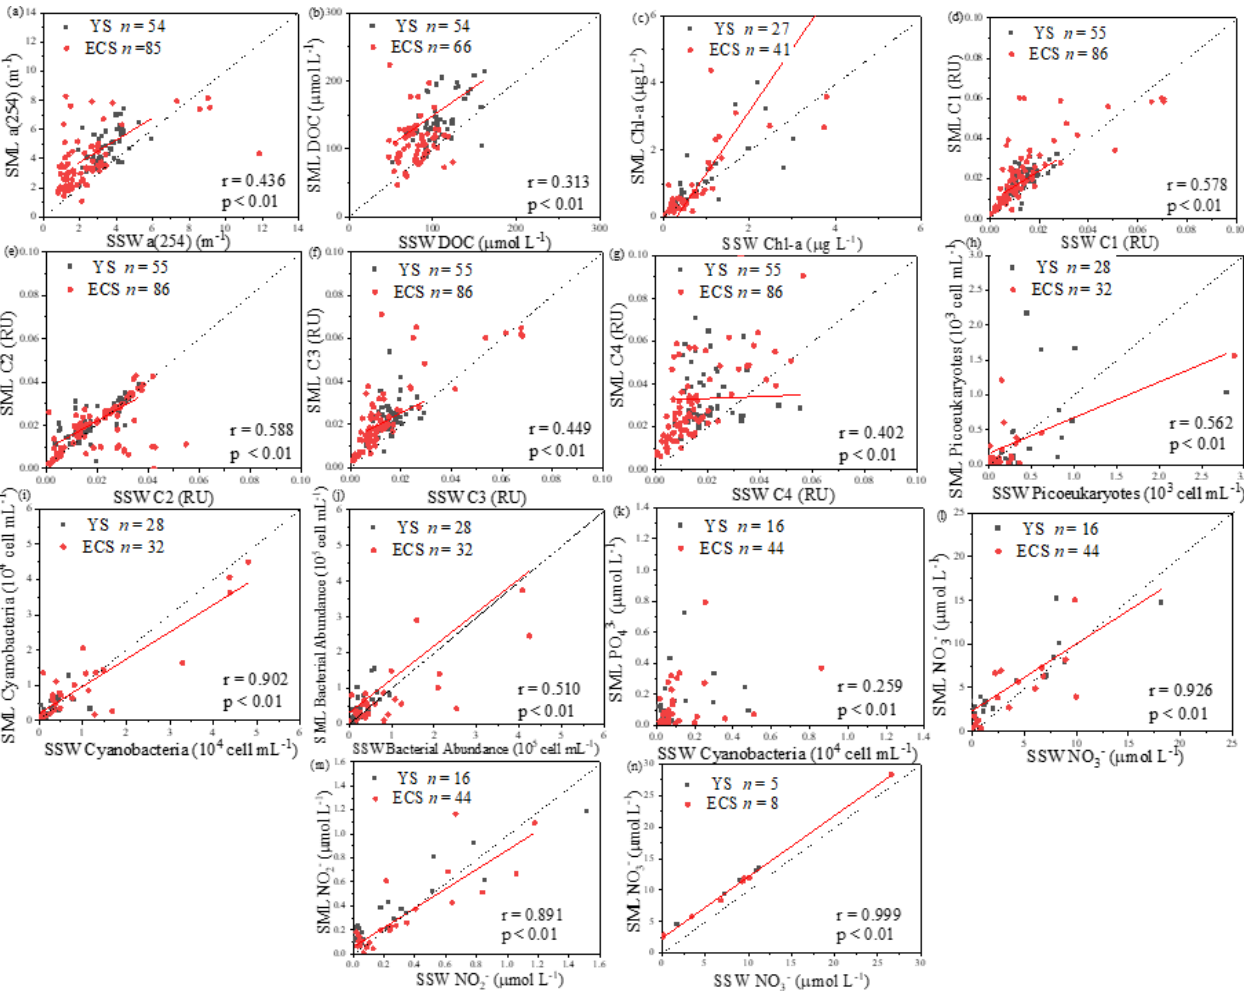
Figure 5. Correlations between the microlayer CDOM, DOC, Chl a , four fluorescence components concentrations, cyanobacteria, phyto- plankton biomass, nutrients and bacterial abundance, as well as their sub-surface water concentrations. The dashed lines correspond to the 1 : 1 lines, and the full lines are the regression models. (All DOM spectroscopic parameter samples were analysed in spring, summer and winter; Chl a was determined in spring, summer and winter; cyanobacteria, phytoplankton biomass, nutrients and bacterial abundance were determined in spring and